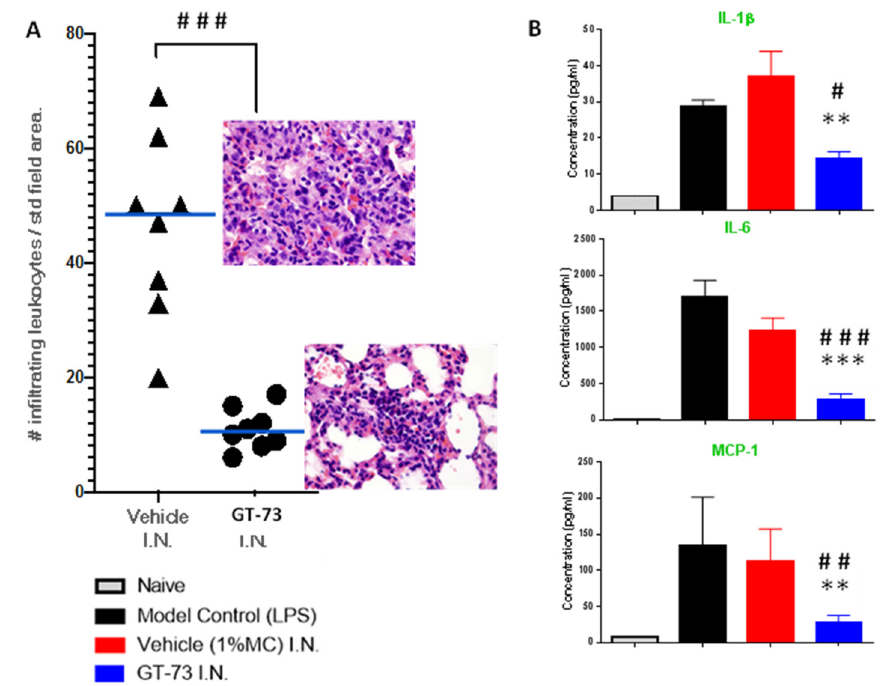
Figure 2. In vivo effect of GT-73. ( A ) Effect of GT-73 on the number of leukocytes in the lungs. Female BALB/c mice were anesthetized and orally intubated with a catheter and challenged with intratracheal instillation LPS (800 µg) in PBS. Mice were euthanized at 3 d after LPS challenge to collect tissues for analysis. All animals from the treatment group were administered GT-73 (5 mg/kg in 1% methyl cellulose) for 3 h after LPS application by the intranasal route 3 times a day. Lungs were collected in 10% buffered formalin, embedded in paraffin, and cut into sections. Sections were stained with hematoxylin/eosin, and images were taken with an Olympus BX53 microscope. ( B ) Samples of BALF were centrifuged. The supernatant was flash-frozen, and the cytokine levels were measured. n = 7, MEAN ± SD, significant difference between treated by GT-73 and vehicle groups, # p ≤ 0.004, ## p ≤ 0.003, and ### p ≤ 0.0001. Significant difference between treated by GT-73 and model control groups ** p ≤ 0.003, and *** p ≤ 0.0001.